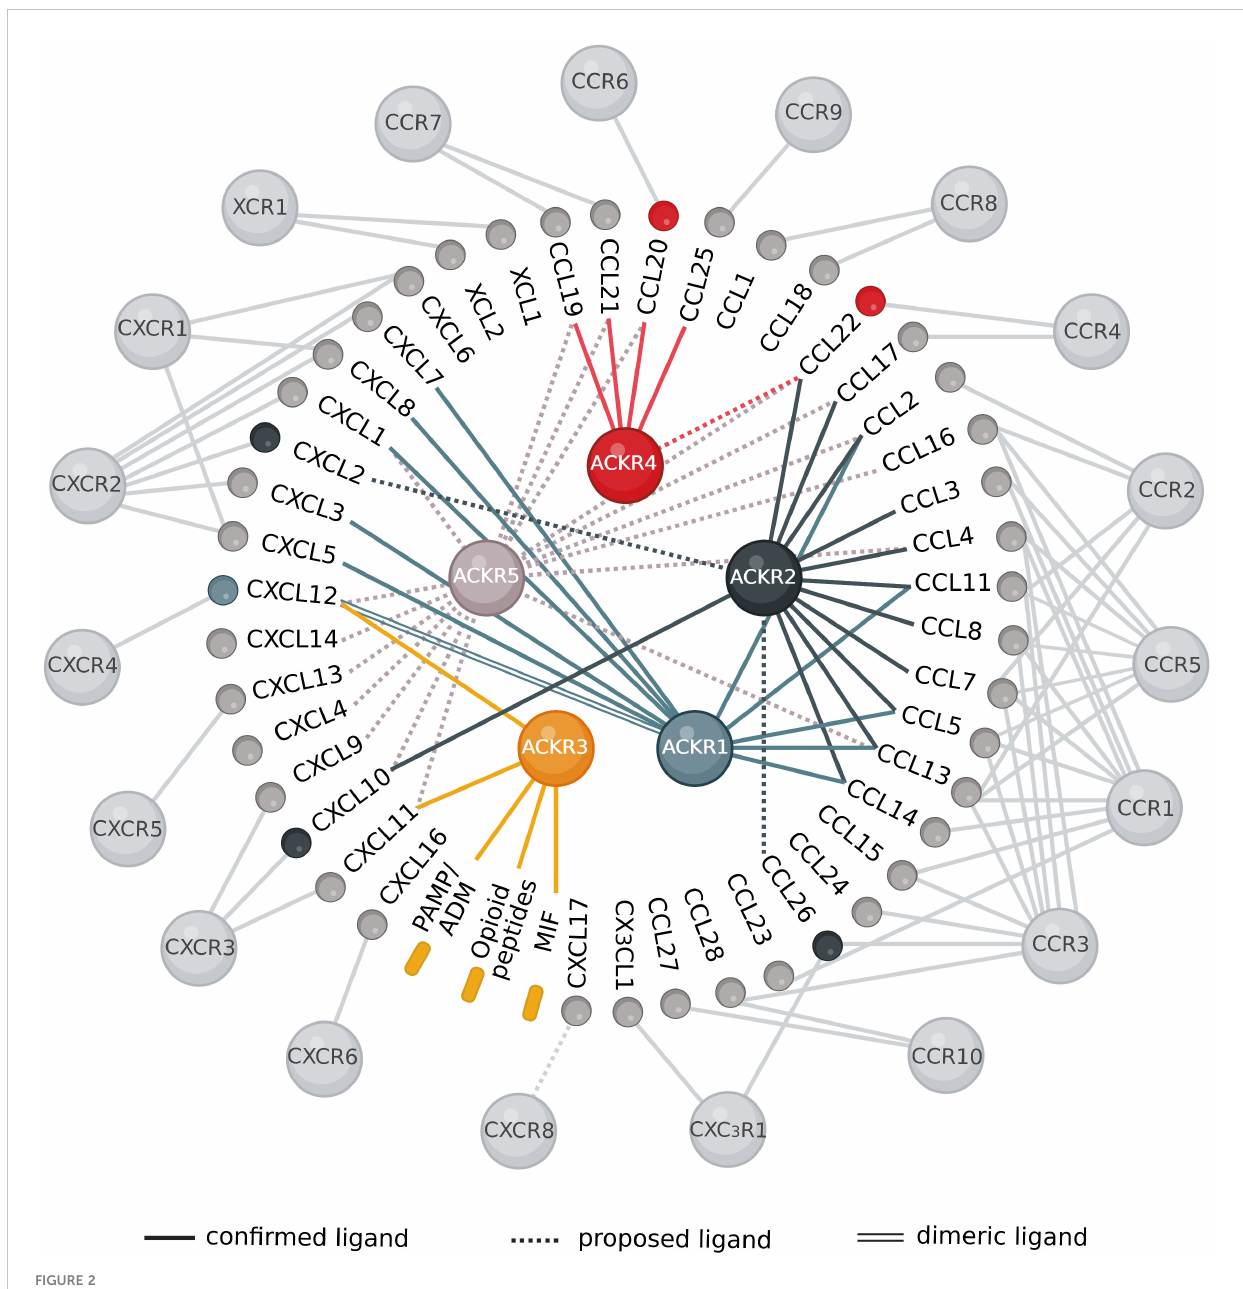
FIGURE 2 Overview of the chemokine interaction network with classical and atypical receptors. The interactions between different chemokines and their signaling and regulatory receptors are highly promiscuous. Most chemokines can bind several receptors and the majority of the receptors have multiple ligands. Receptors and chemokines are represented as spheres, while non-chemokine ligands are represented as rounded rectangles. There are 45 chemokines, 19 classical chemokine receptors (light grey) and 5 atypical chemokine receptors: ACKR1 (light blue), ACKR2 (dark blue), ACKR3 (yellow), ACKR4 (red) and the newly proposed ACKR5/GPR182 (light grey). Colored chemokines and non-chemokine ligands represent recently identi fi ed pairings, dashed lines indicate proposed ligands and double lines designate the binding of the dimeric ligand to the receptor. Created with